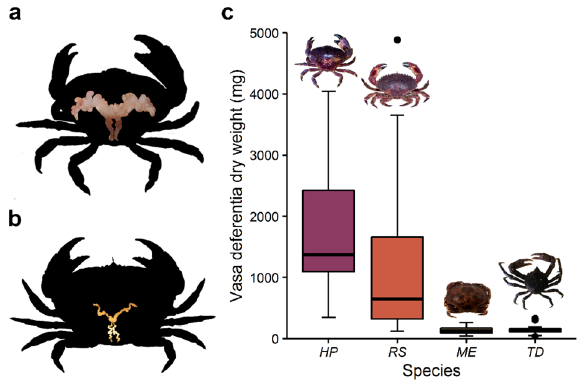
Figure 1. Differences in size and complexity of the vasa deferentia of the brachyuran species studied. ( a ) Large and complex in Homalaspis plana . ( b ) Small and simple in Metacarcinus edwardsii . ( c ) Box plot of annual dry weight of paired vasa deferentia. HP , RS , ME, and TD refer to H. plana , Romaleon setosum , M. edwardsii and Taliepus dentatus , respectively. Boxes: interquartile range of the data (first quartile, median and third quartile). Whiskers: the values that extend to 1.5 times the interquartile range. Circles: